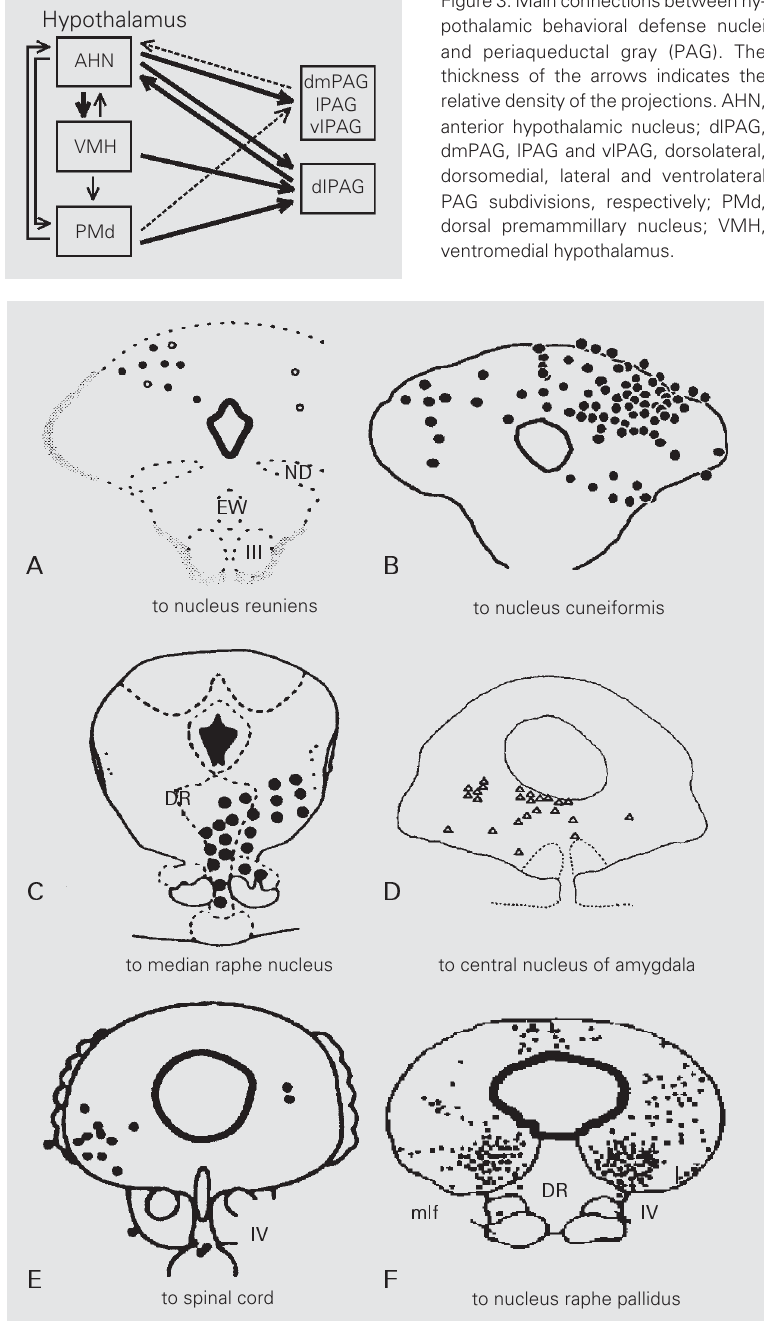
Figure 4. Periaqueductal gray neurons that project to other structures. III, oculomotor nucleus; IV, trochlear nucleus; DR, dorsal raphe nucleus; EW, Edinger-Westphal nucleus; mlf, medial longitudinal fasciculus; ND, nucleus of Darkschewitsch. A , Reprinted from Risold et al. (41) and F , from Hermann et al. (51), (cid:1) 1997, with permission of Elsevier Science. B , Reprinted from Redgrave et al. (49), and E , from Mouton and Holstege (55), (cid:1) 1988, 1994, with permission of Springer-Verlag. C , Reprinted from Marcinkiewicz et al. (44), and D , from Rizvi et al. (35), (cid:1)(cid:2) 1989, 1991, with permission of Wiley-Liss, Inc., a subsidiary of John Wiley &